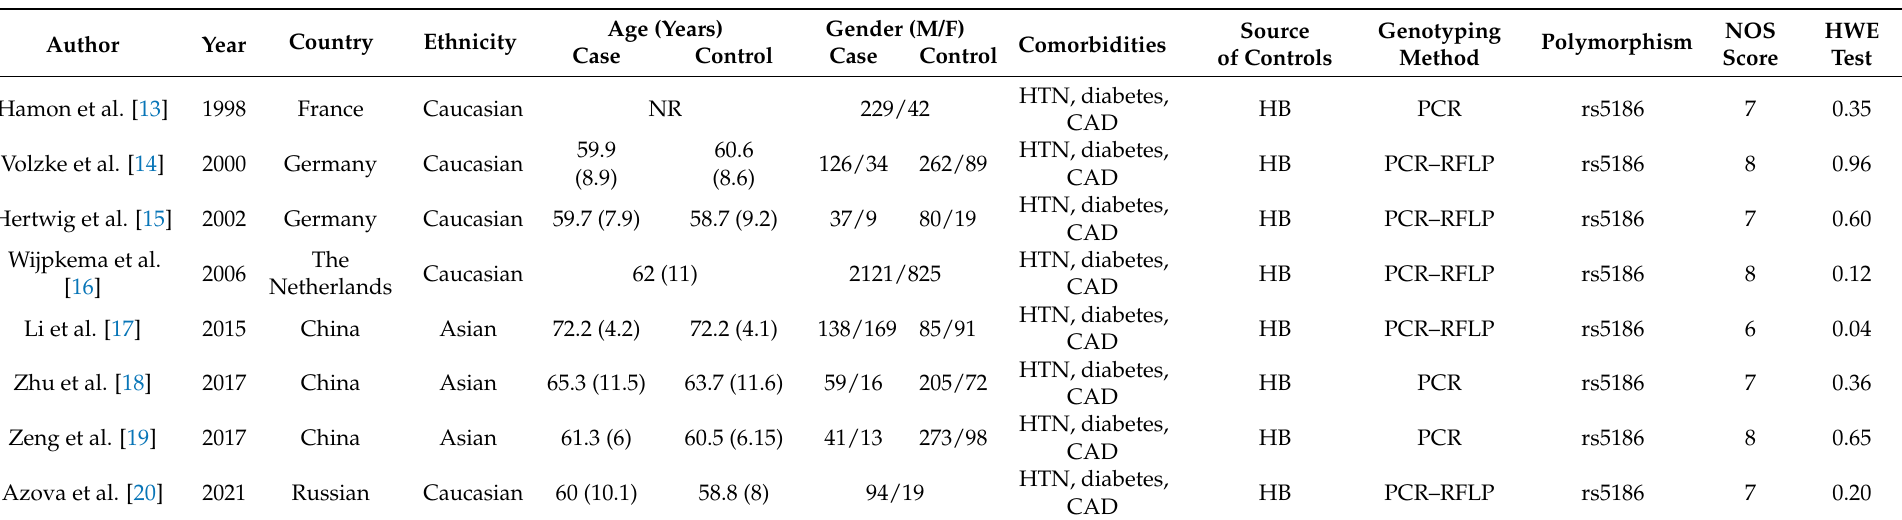
Table 1. Characteristics of the studies included for